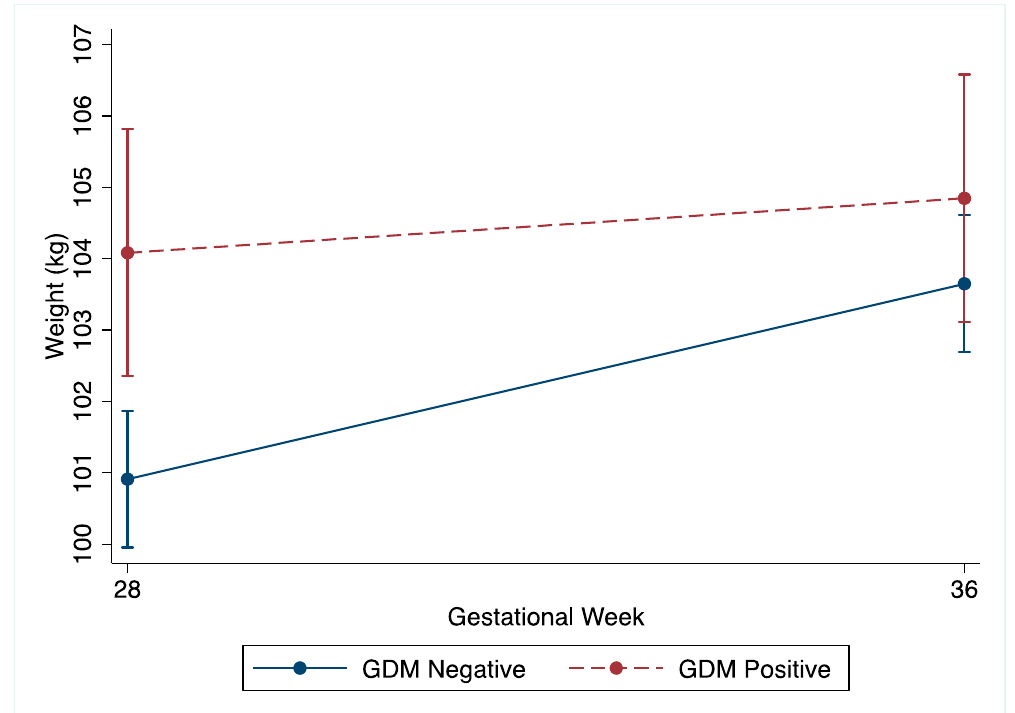
Figure 2. Unadjusted weight (kg) change of GDM and non-GDM women from 27 +0 –28 +6 weeks’